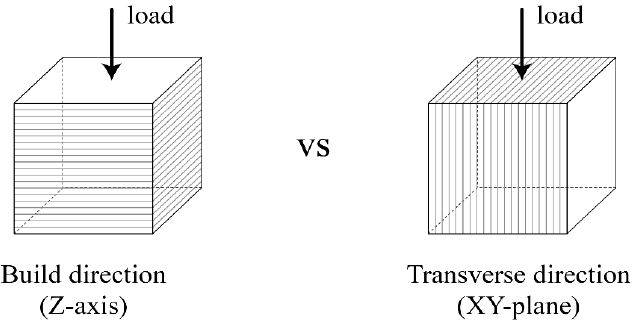
Figure 4. Loading for compressive strength considering build orientation.